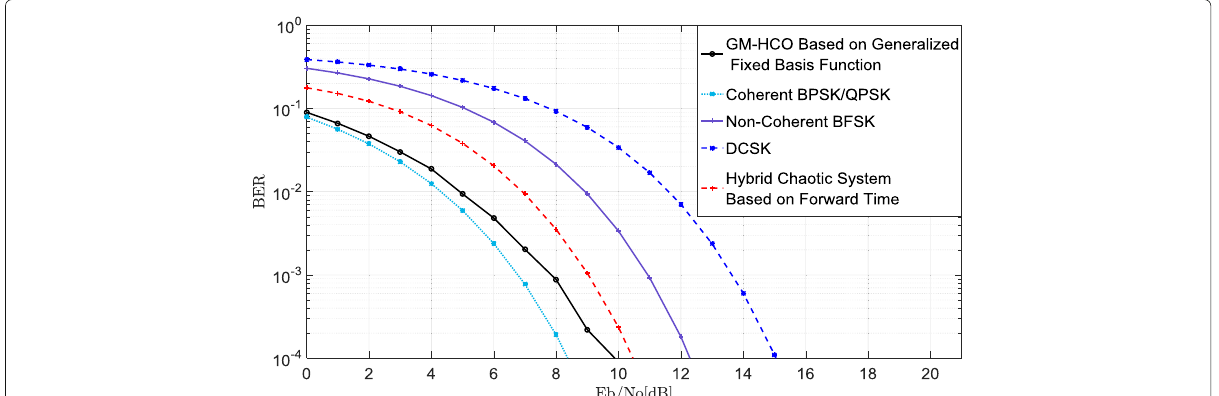
Fig. 13 BER performance of the proposed system based on GM-HCO for two levels over AWGN